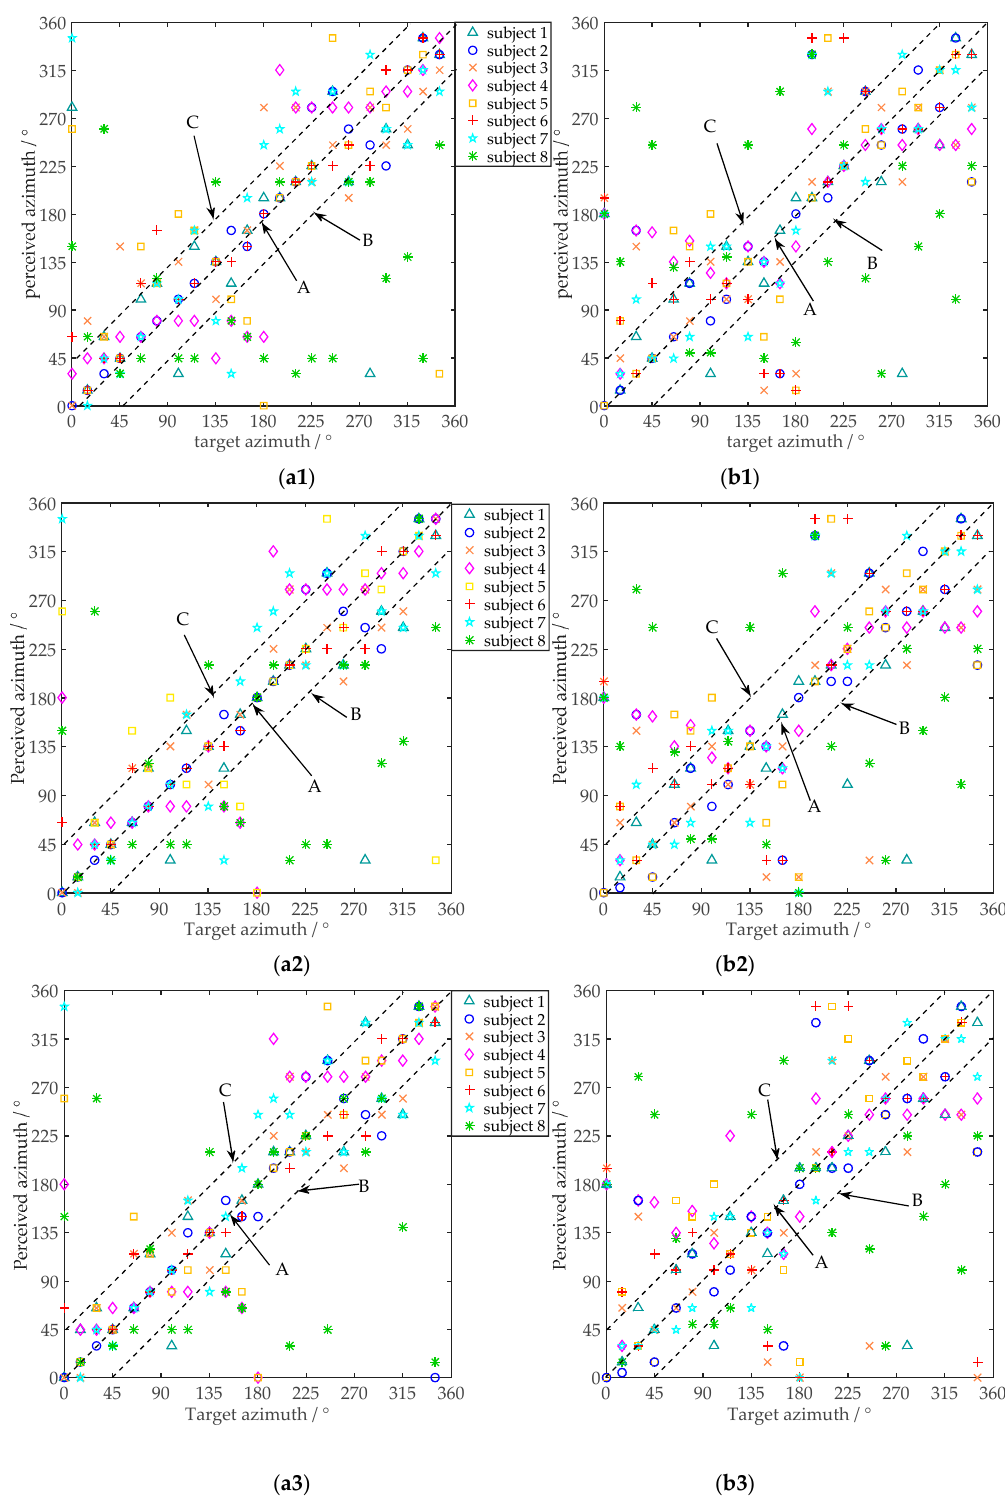
Figure 13. Results of the subjective localization experiments, ( a1 ) ‒ ( a3 ) denote the results of the three repetitions for the presented individualized HRTFs, ( b1 ) ‒ ( b3 ) denote the results of the three repetitions for non-individualized HRTFs. Different markers denote the results of different subjects, points on line A denote the correct perception results, points between line B and line C denote the results with minor localization errors.